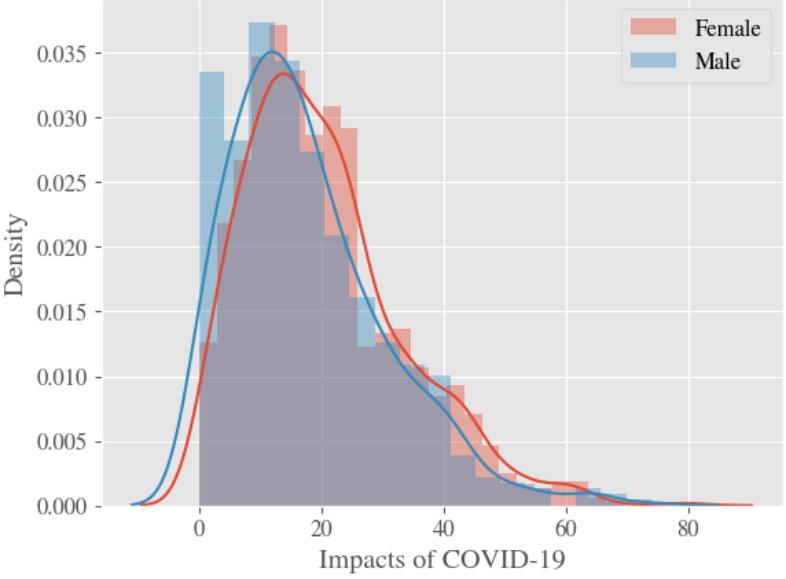
Figure 3. The Distribution of Levels of Anxiety in Men and Women.